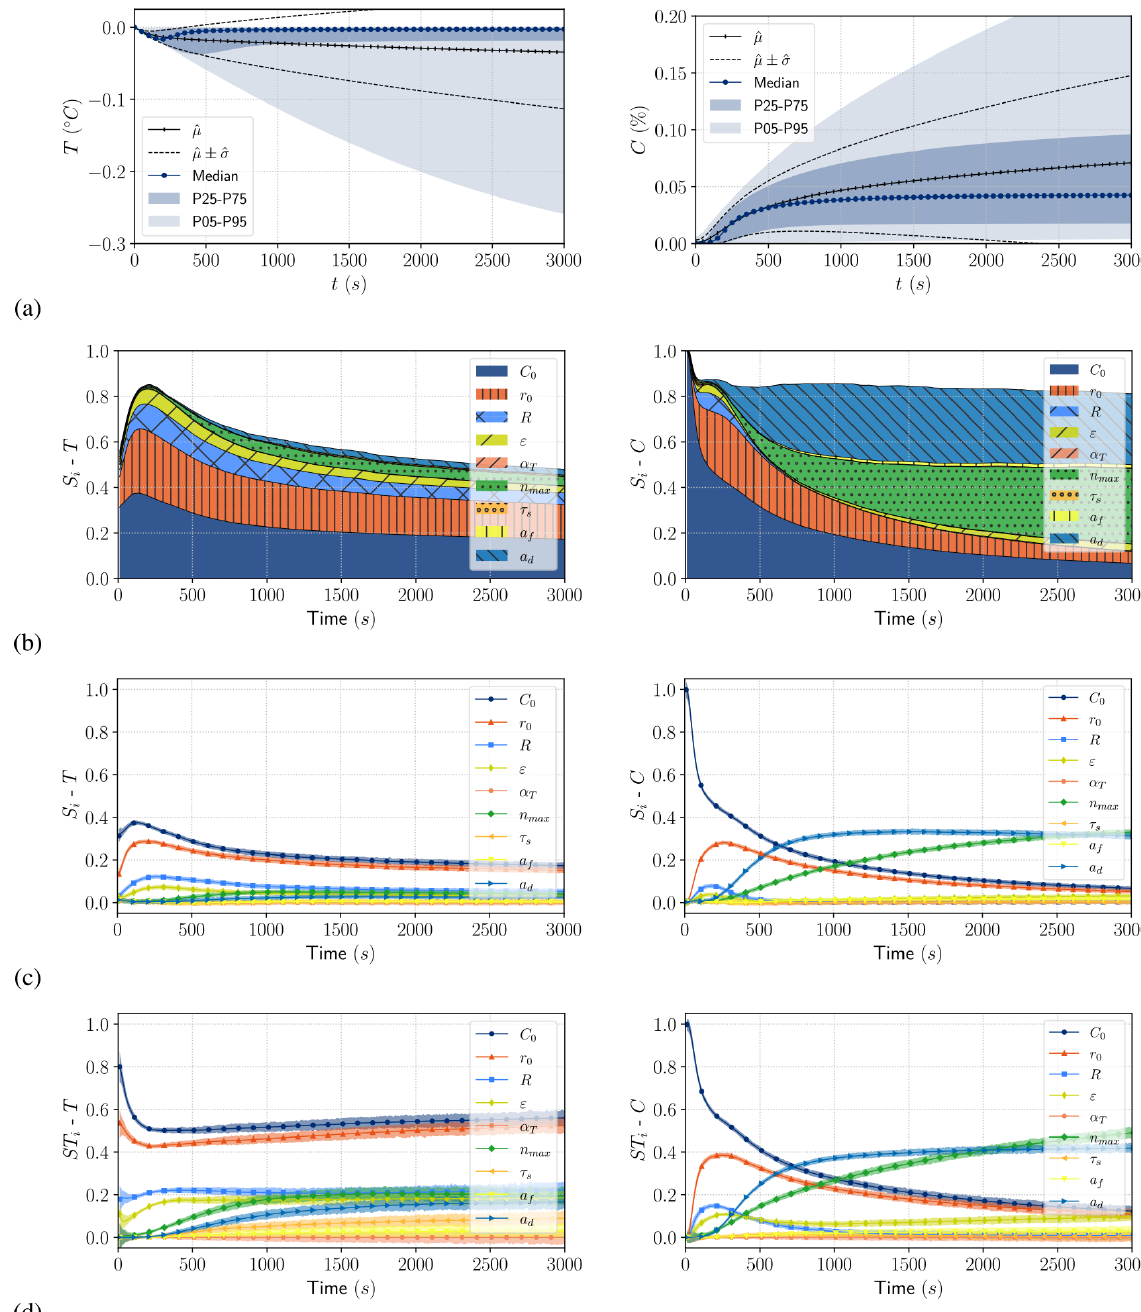
Figure I1. Results of case 4. From top to bottom: uncertainty propagation result (a) , first-order Sobol indices (b) , first-order Sobol indices with 95% confidence intervals (c) , and total-order Sobol indices with 95% confidence intervals (d) for temperature (left panels) and frazil (right